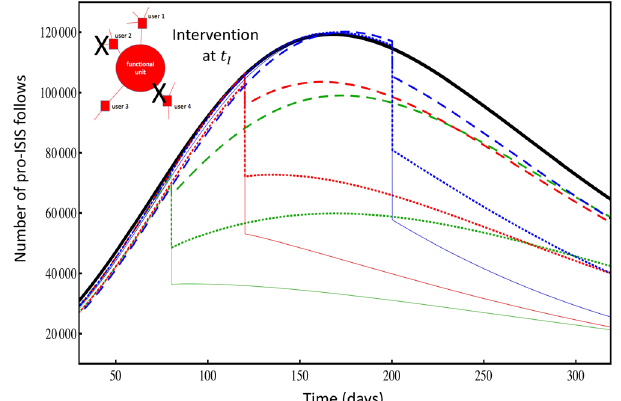
Figure 4. Impact of interventions. The impact of one-off intervention at time t I , as described in the text and inset, is quantified by our mathematical model used in Fig. 3(d). Colors represent the moment of intervention t I in units of days (vertical gray lines): green t I = 80, red t I = 120, blue t I = 200. Line types represent the size of the intervention, i.e. percentage of follows that are randomly removed at time t I : dashed line 10%, dotted line 30%, solid line